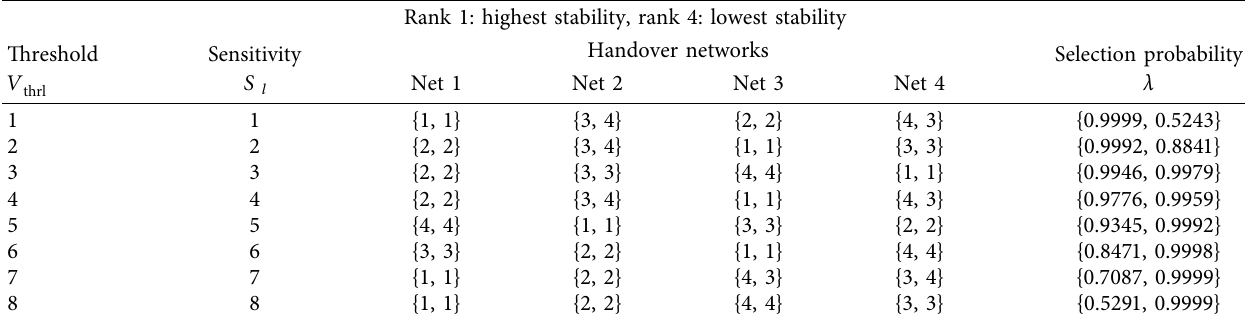
Table 7: Network handover ranking map as a function of threshold, sensitivity, and selection probability. Rank 1: highest stability, rank 4: lowest stability